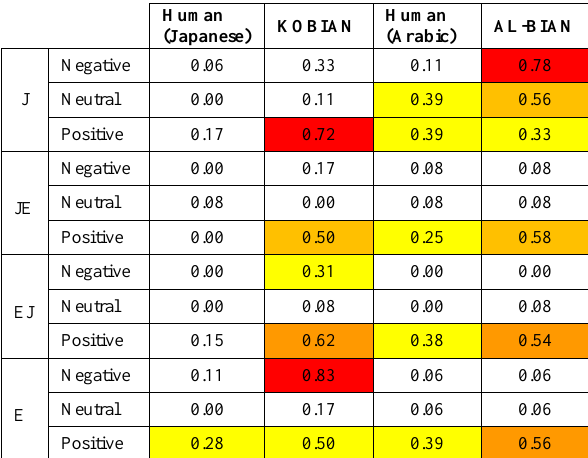
Table 6. Average number of occurrences of non-verbal cues per subject.